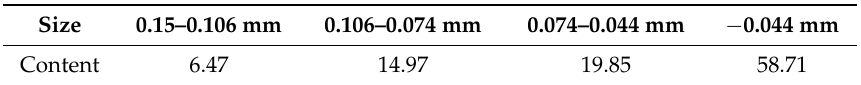
Table 2. Particle size of pyrite cinder (mass/%).